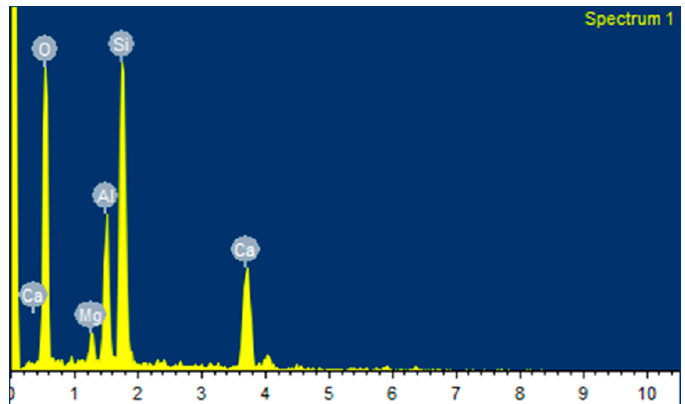
Figure 7. Cupula slag chemical analysis. Table 4. Chemical composition of the cupola slag (principal components).